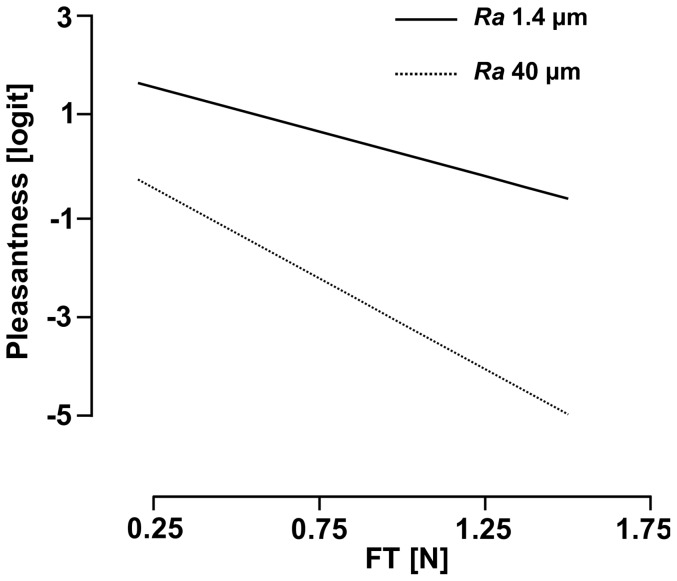
Illustration of the interaction effect between Ra and FT.